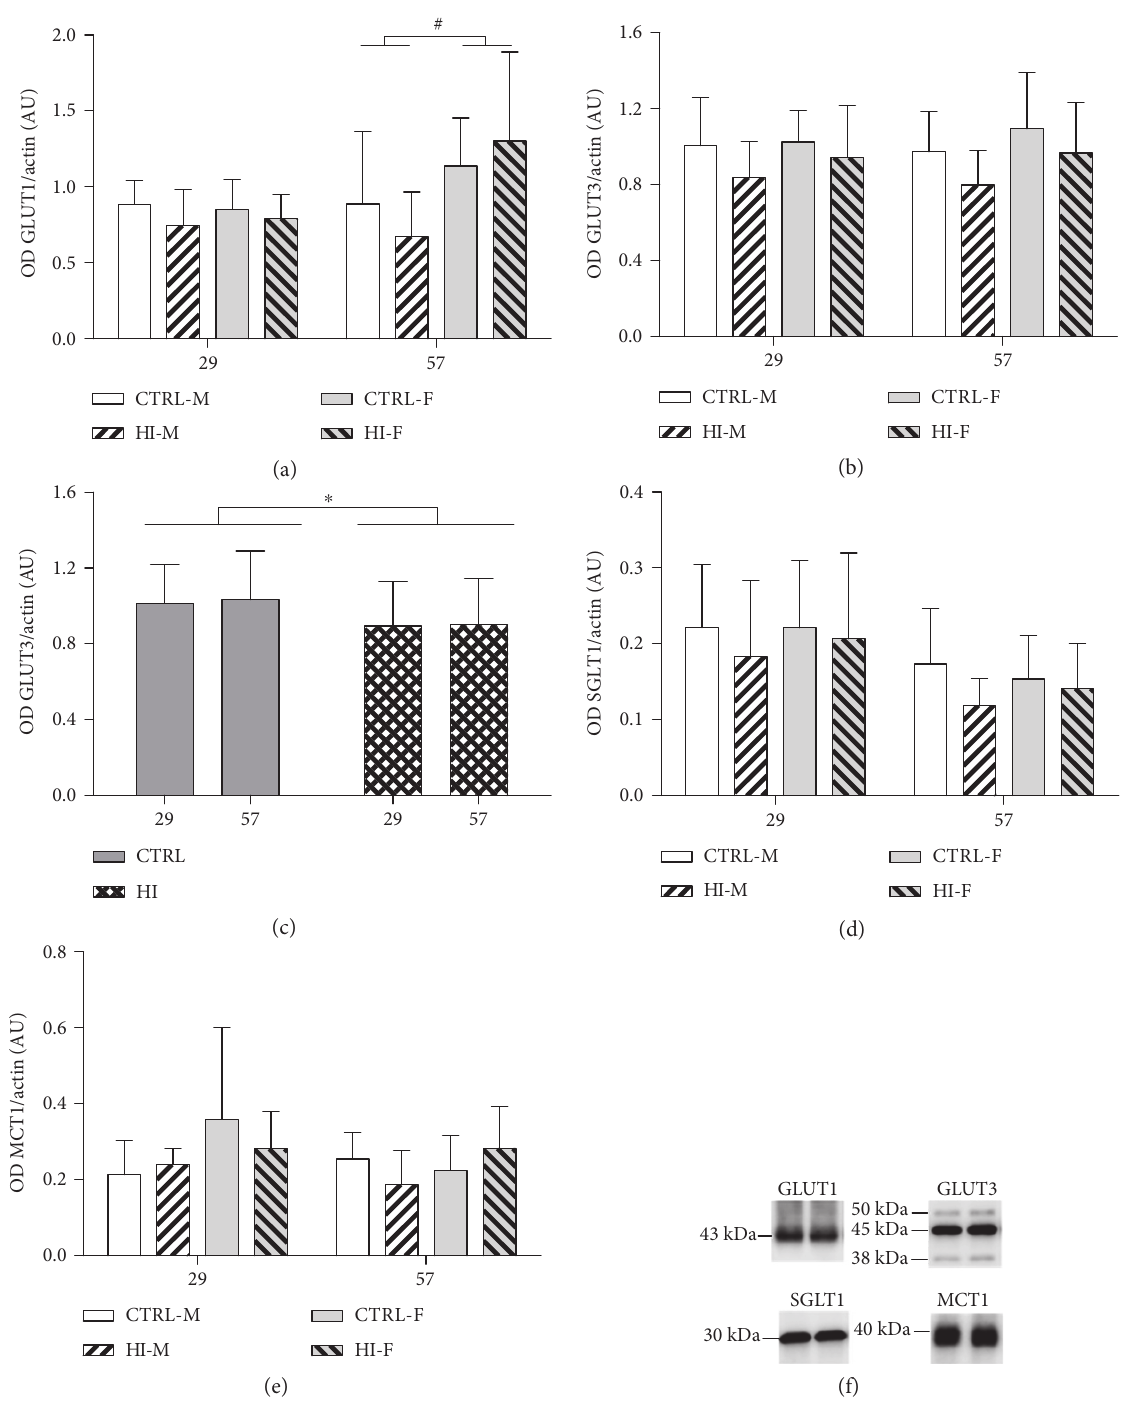
Figure 3: Relative protein levels of substrate transporters at the two di ff erent time points during infusion. Mean+SD. (a) GLUT1, each day depicted separately, (b) GLUT3, each day depicted separately, (c) GLUT3, overall e ff ect of HI-dosing, sex pooled. (d) SGLT1 and (e) MCT1, each day depicted separately. (f) Representative pictures of the western blots. CTRL-M: n = 7 − 10 , HI-M: n = 4 − 8 , CTRL-F: n = 6 − 9 , and HI-F: n = 6 − 10 . OD: optical density, AU: arbitrary units. Actin levels were used as an internal reference. ∗ p < 0 05 for e ff ect of treatment; # p < 0 05 for e ff ect of